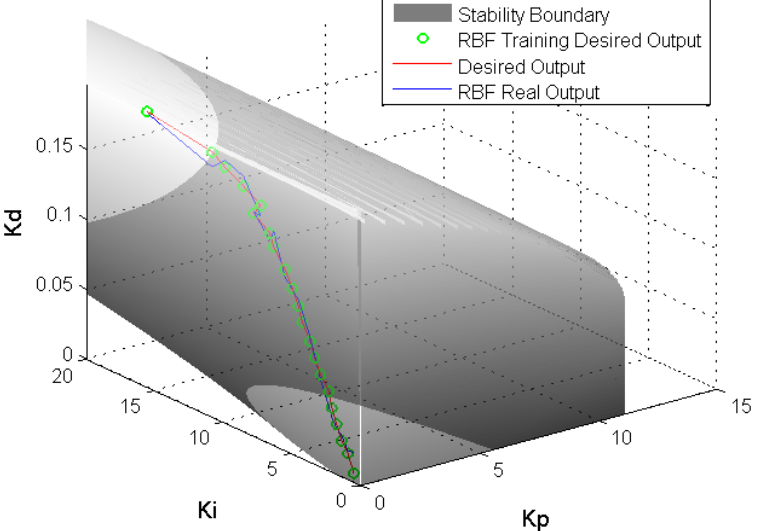
Figure 12. The 3D stability boundary in the parameter space.